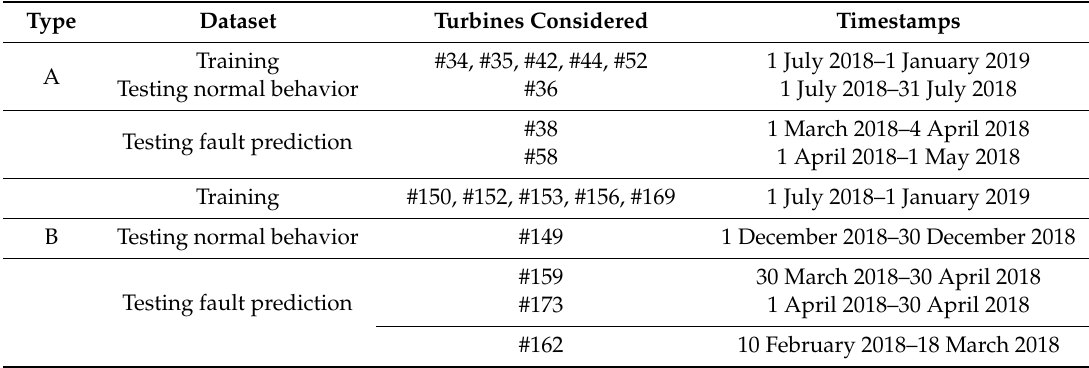
Table 2. Description of modeling datasets.